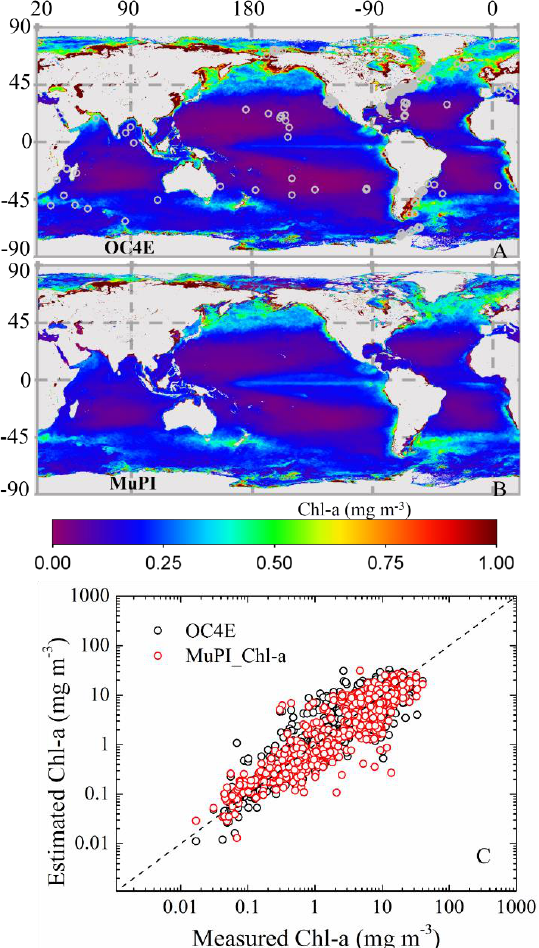
Figure 7. Global distributions of chlorophyll a concentration estimated from 2007 MERIS L3 R rs ( λ ) imagery using NASA standard algorithm OC4E ( A ) and MuPI model ( B ). The locations ( o ) of in situ Chl-a and MERIS R rs ( λ ) matchups for further comparison of OC4E and MuPI were plotted on the OC4E Chl-a map. C : Chlorophyll a concentration (Chl-a) from in situ measurements and from those estimated from matchups of MERIS R rs ( λ ) using OC4E and MuPI algorithms with mean UAPD of 48.8% and RMSE of 4.51 mg · m − 3 for OC4E and mean UAPD of 49.3% and RMSE of 4.05 mg · m − 3 for MuPI.